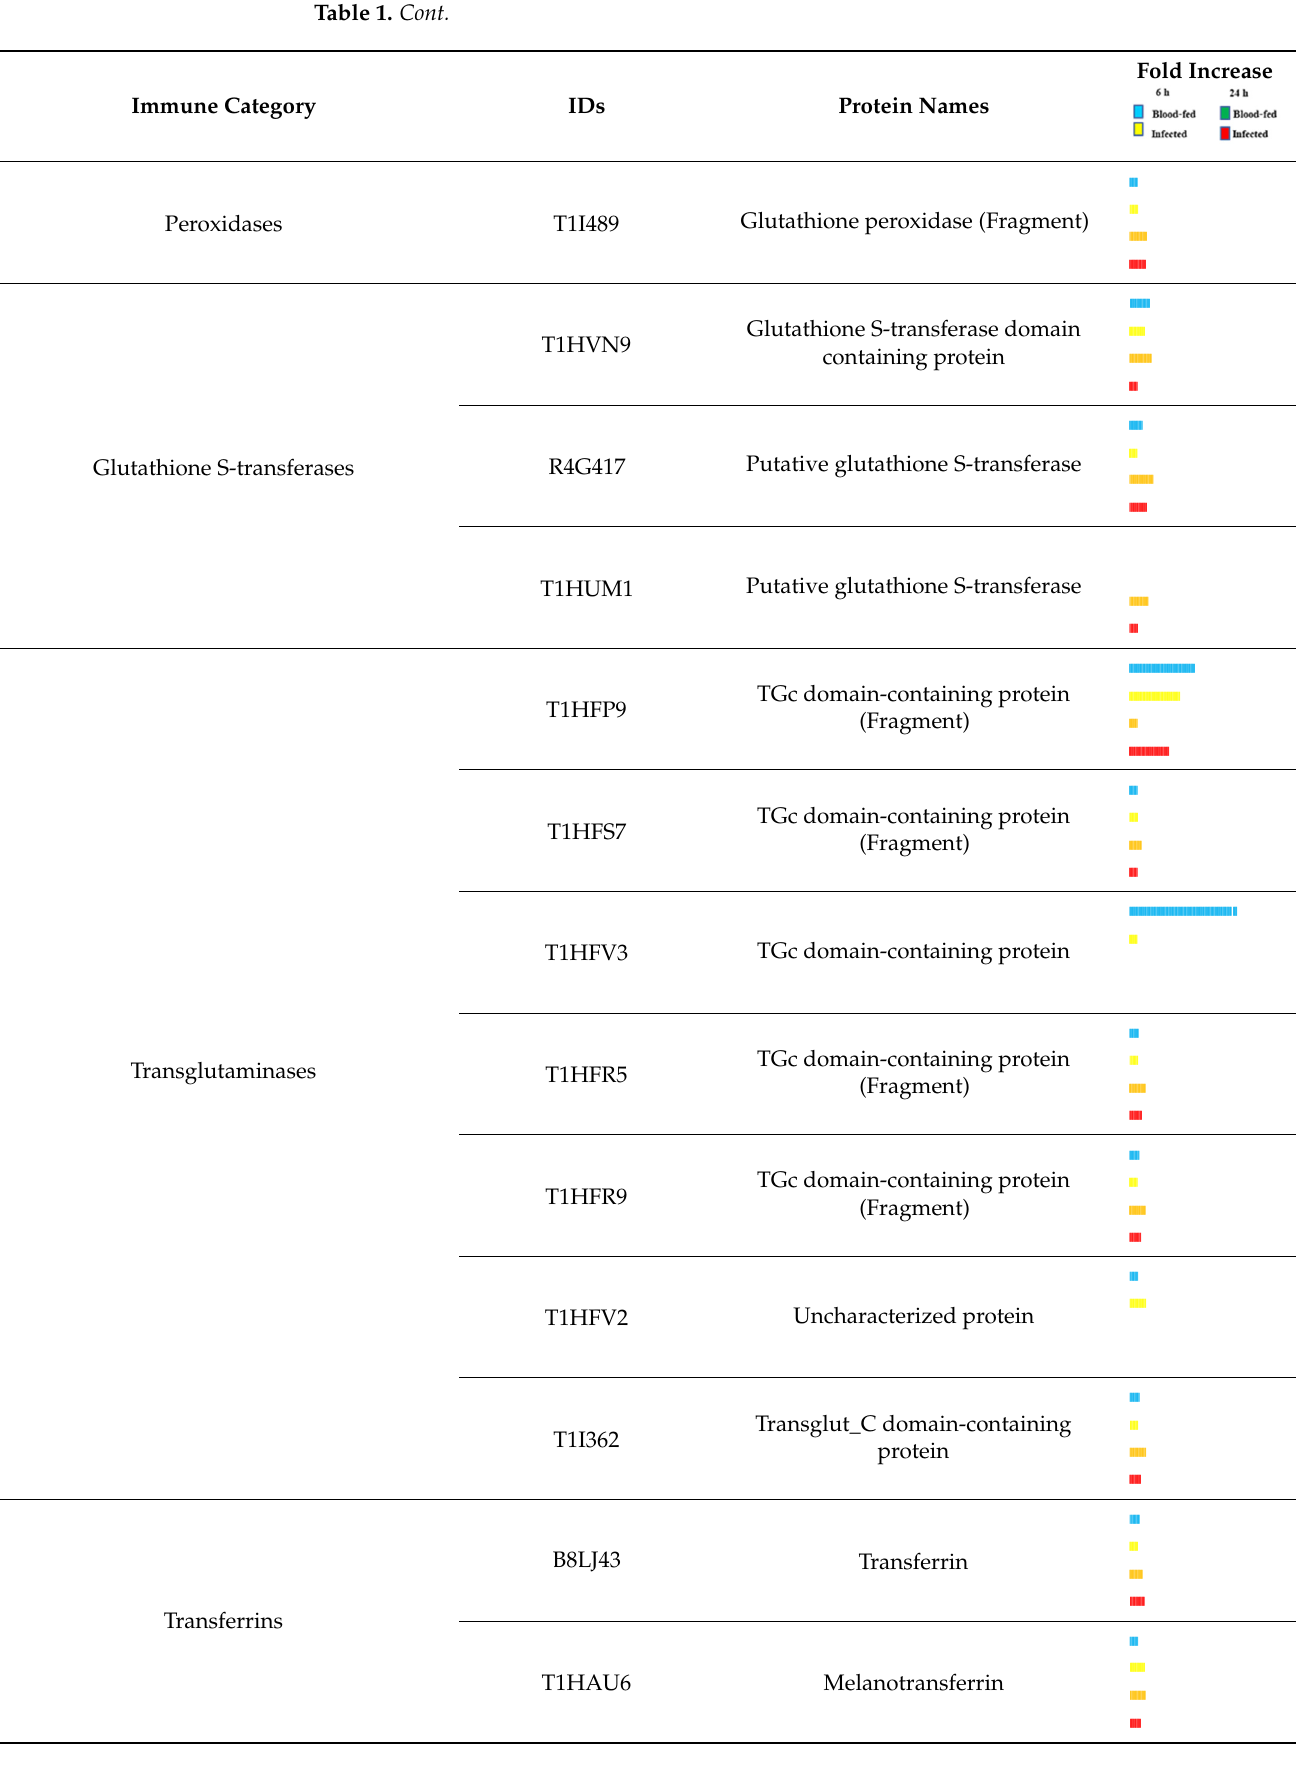
Table 1. Expression pattern of immunity related proteins identified in R. prolixus